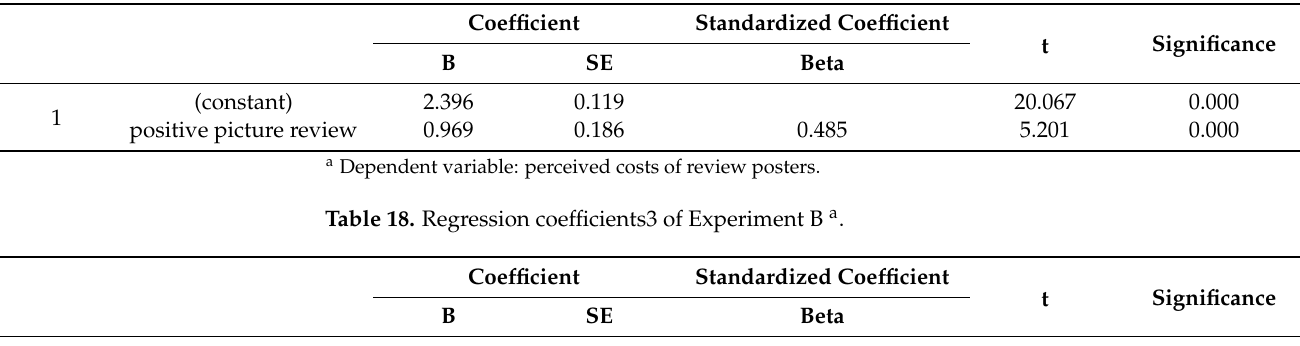
Table 17. Regression coefficients2 of Experiment B a .